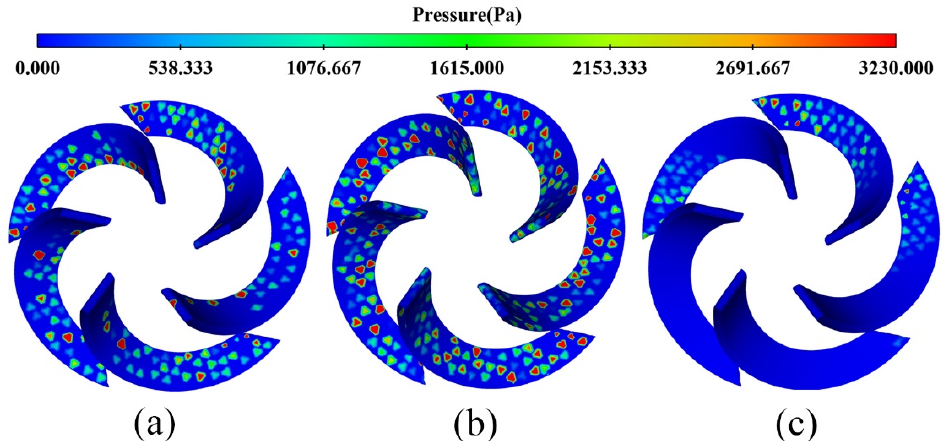
Figure 9. Pressure cloud on the guide vane after being collided with 20–30 mm particles: ( a ) pressure cloud graph at 2 s; ( b ) pressure cloud graph at 10 s; ( c ) pressure cloud graph at 15 s.